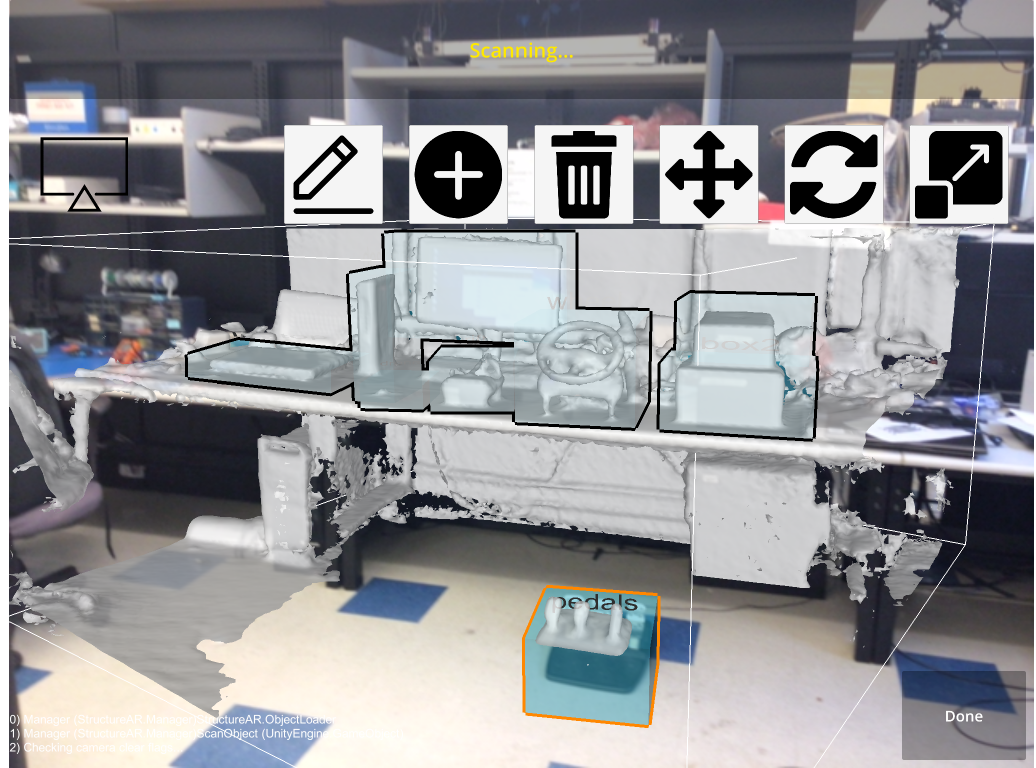
Figure A2: Screenshot of environment 3 after a user completed scanning and annotation using Augmented Annotations. Note the high amount of clutter and occlusion in multiple